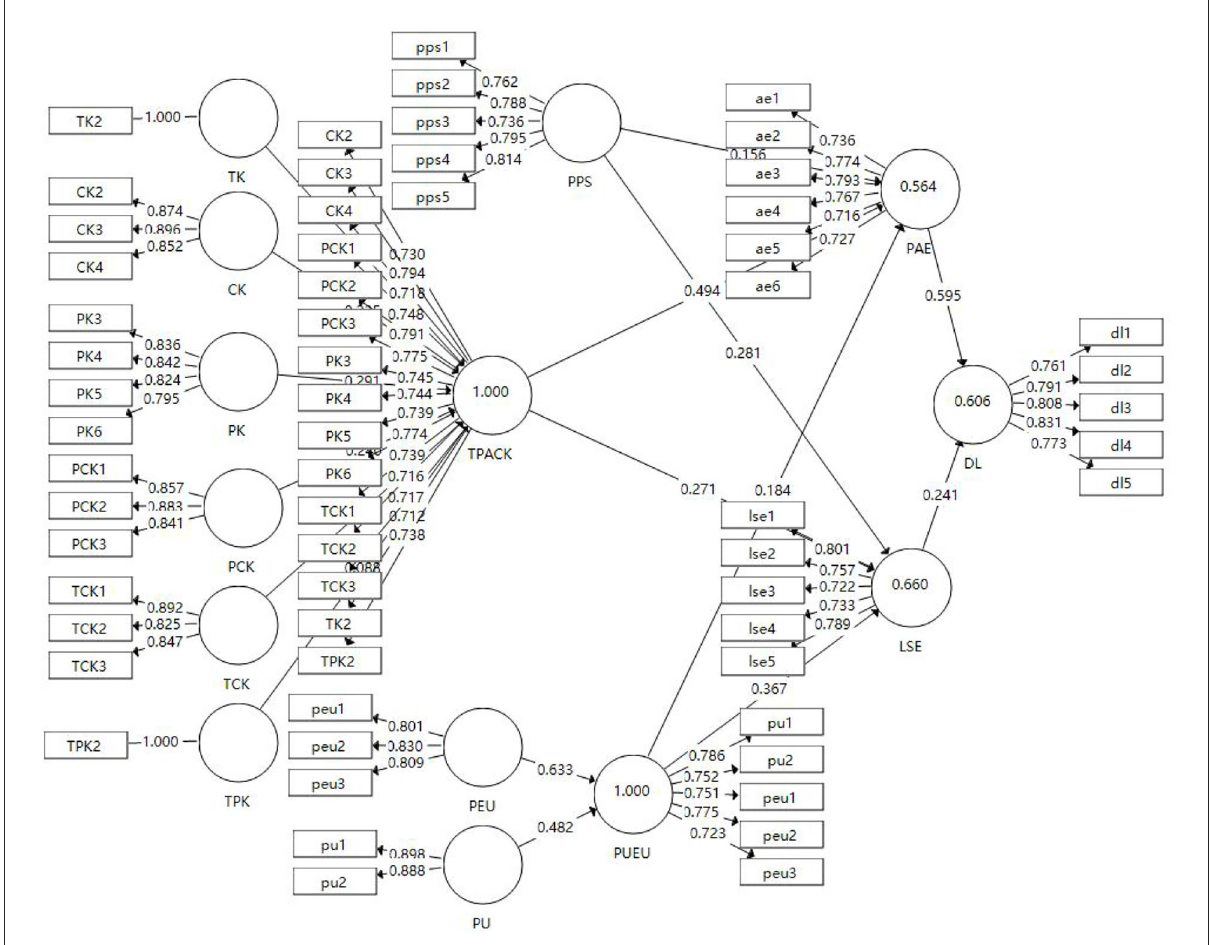
FIGURE2 PLS-path analysis of R 2 values ( n = 300).